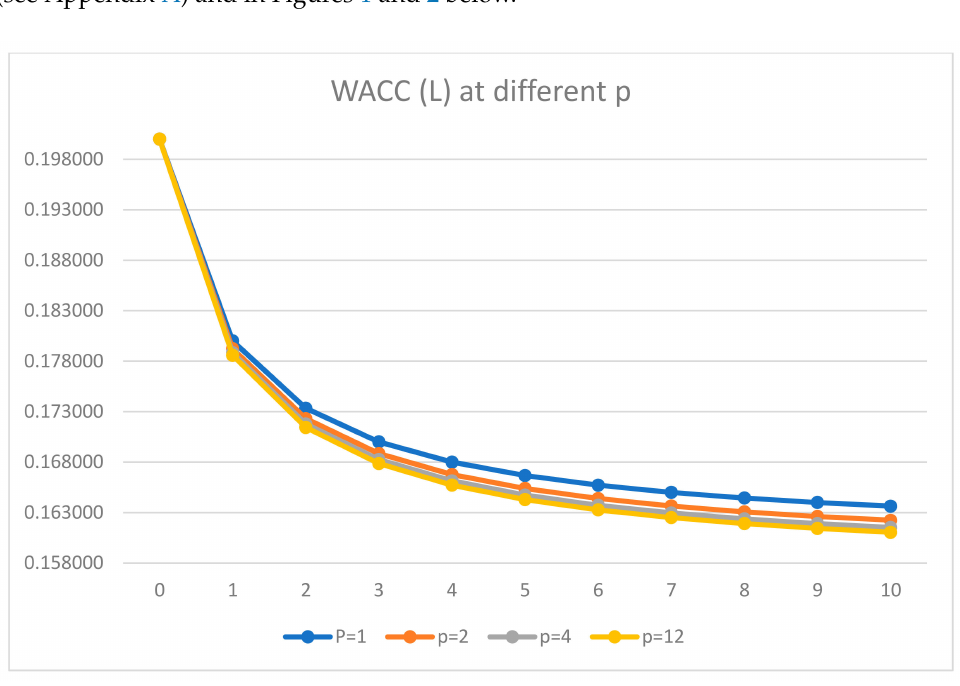
Figure 1. Dependence of the weighted average cost of capital ( WACC ) on leverage level L at different frequency of payment of tax on profit p and fixed k d =